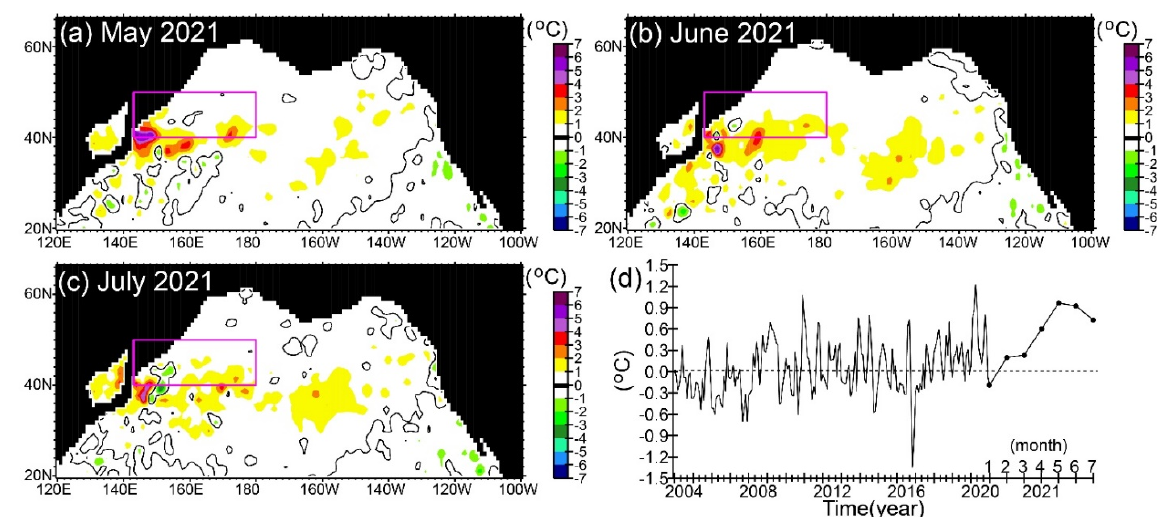
Figure 5. Monthly seawater temperature anomalies at 20 m below the sea surface in ( a ) May, ( b ) June, and ( c ) July 2021. ( d ) Monthly time series of the temperature anomalies averaged over the focal area (143°E–180°, 40°–50°N). In ( d ), the scale of the horizontal axis for the year 2021 has been enlarged. The monthly subsurface temperature anomalies in 2021 are depicted by closed circles connected by a bold line.